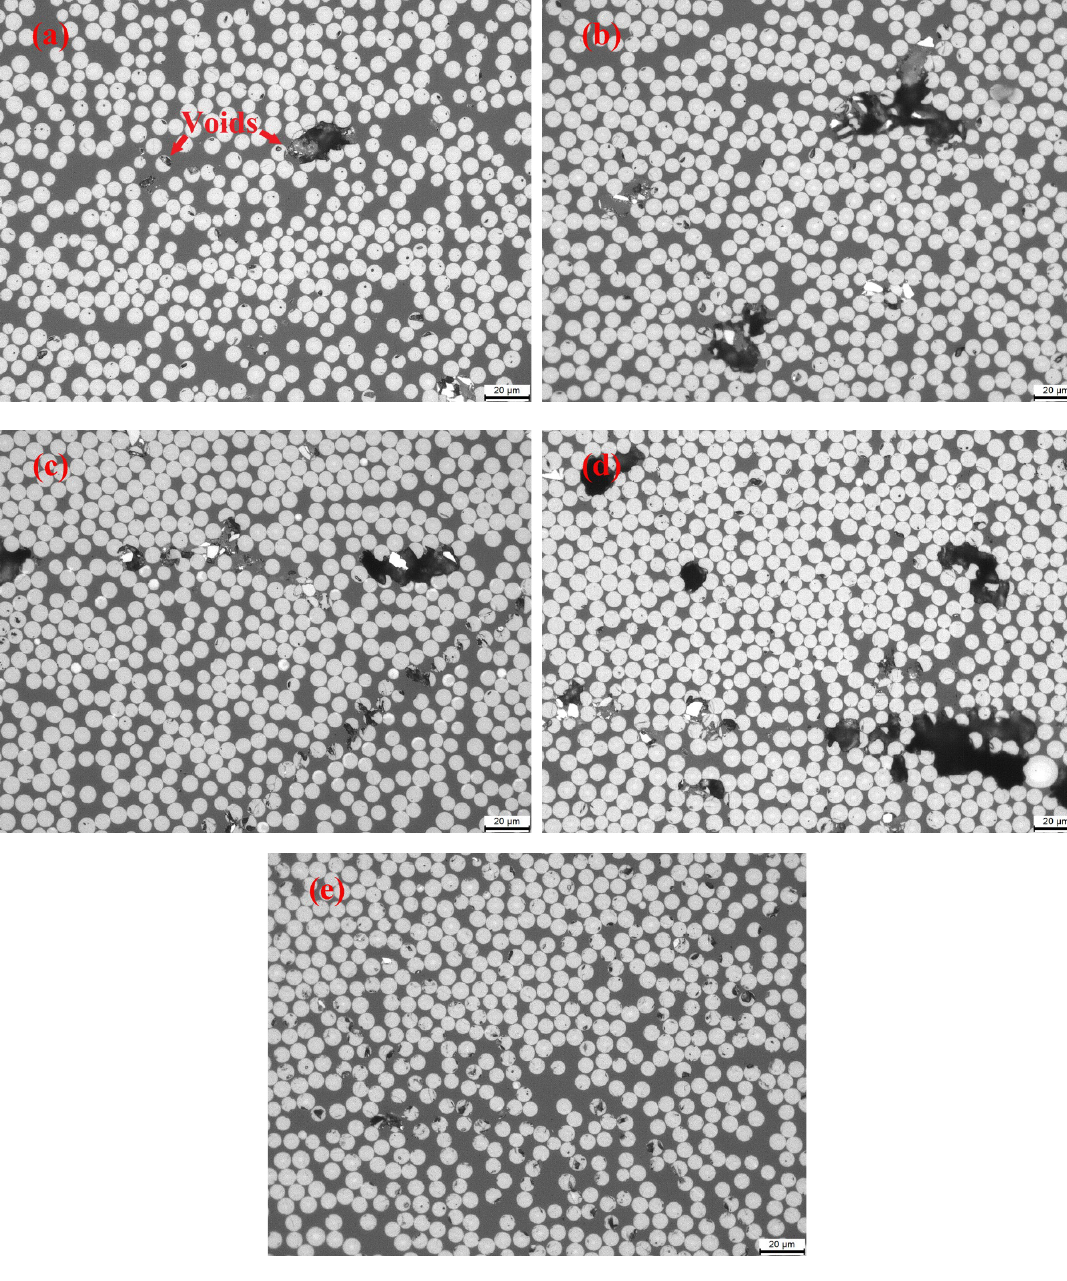
Figure 7. Optical micrographs of ( a ) TC, ( b ) M1, ( c ) M2, ( d ) M3, and ( e ) M4 processed laminates.